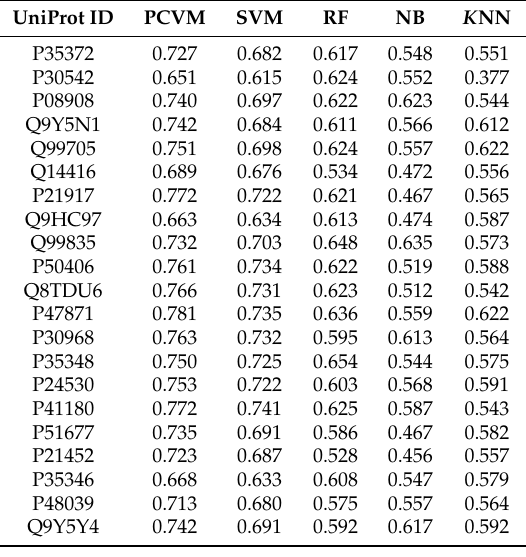
Table 6. Performance comparison of target prediction methods in terms of κ . Scores for the external test set.